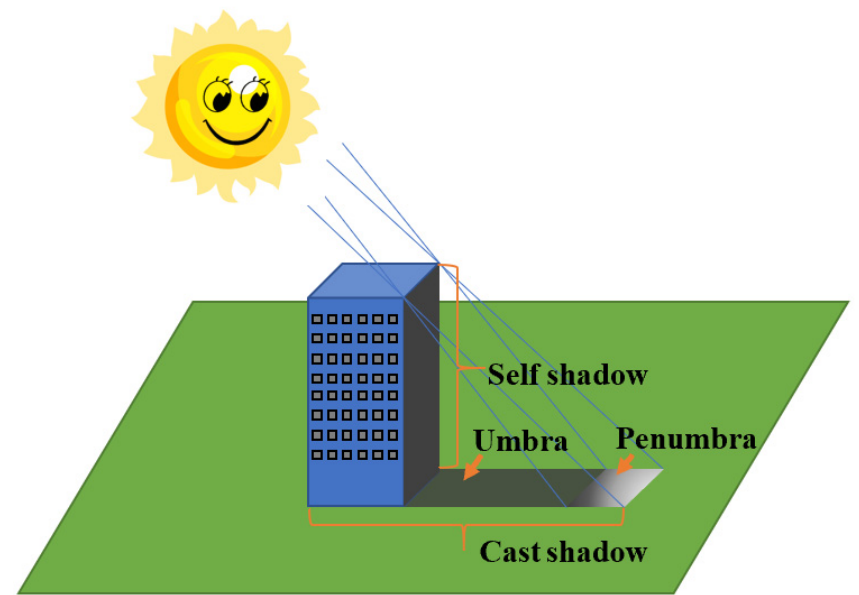
Figure 2. Representation of shadows.